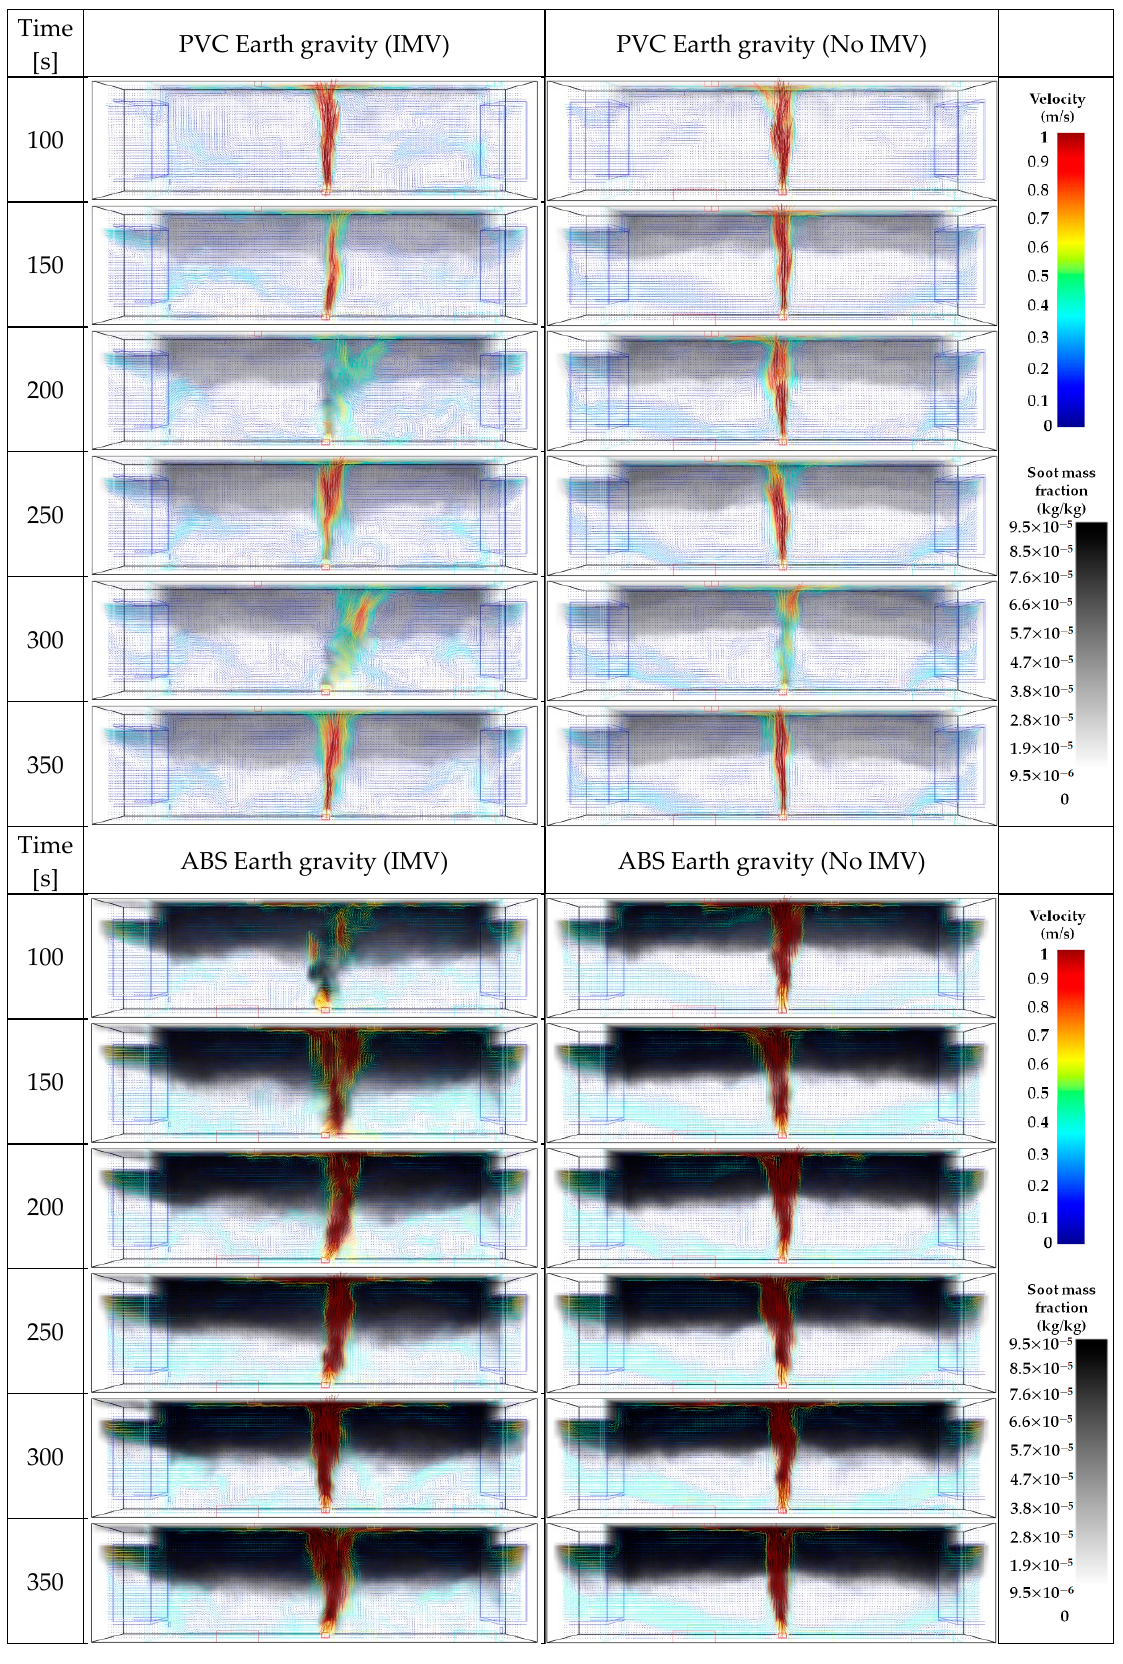
Figure 9. Smoke mass fraction with respect to time of PVC and ABS with and without IMV under Earth gravity.